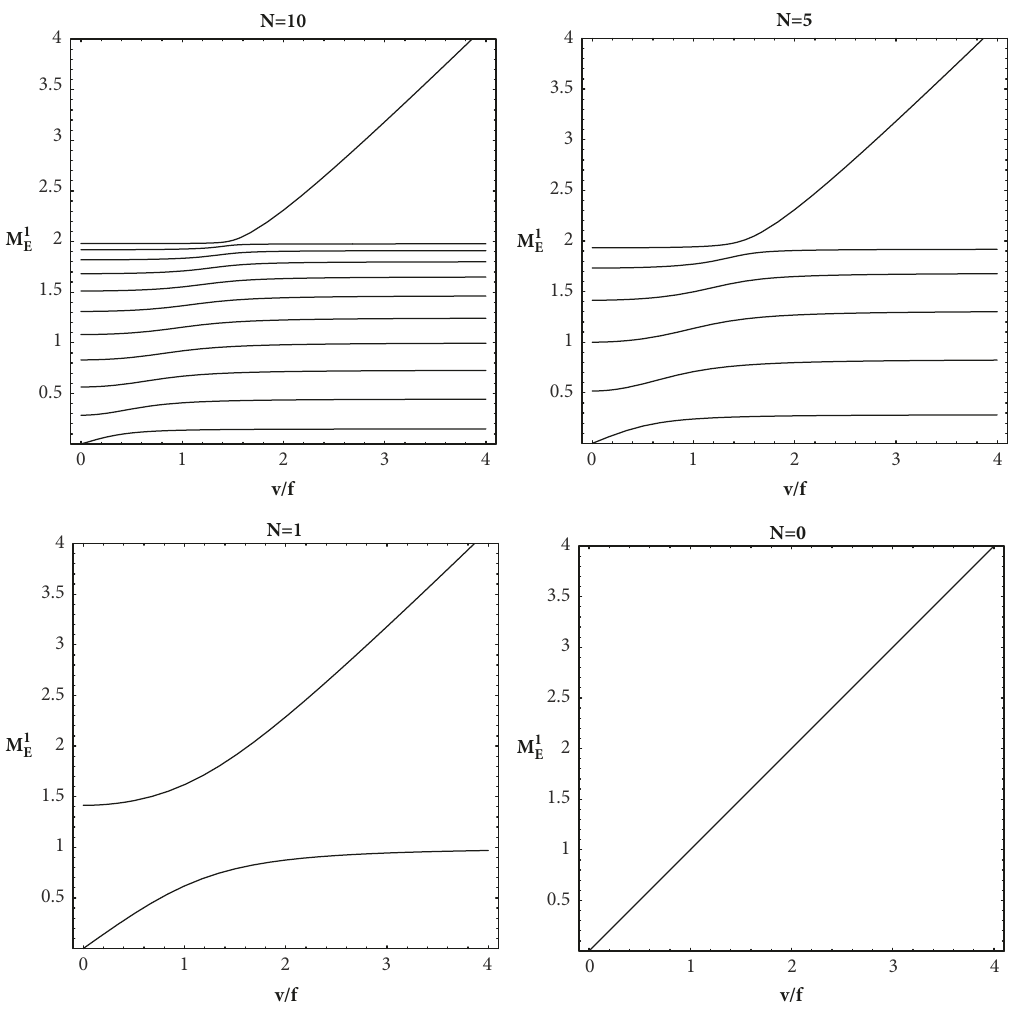
Figure 1: The eigenvalues 𝑀 1 퐸 are shown as functions of V /𝑓 in the cases of 𝑁 = 10,5,1, and 0